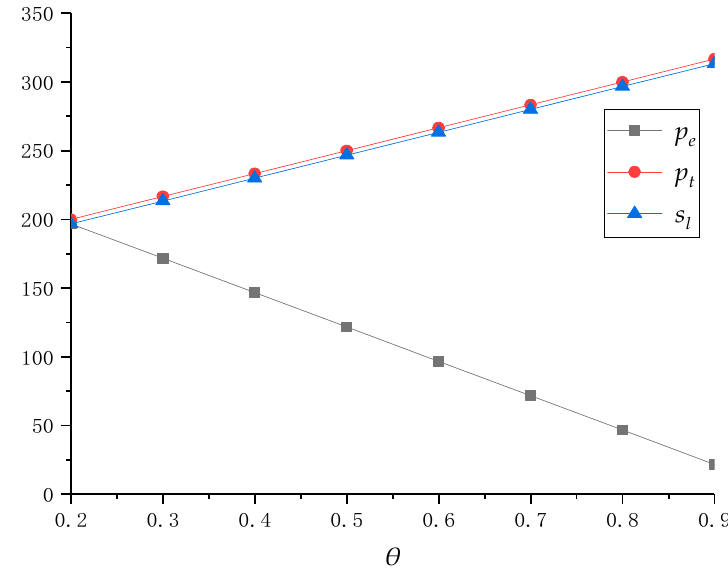
Figure 3. Price and service changes with different θ when μ = 4.